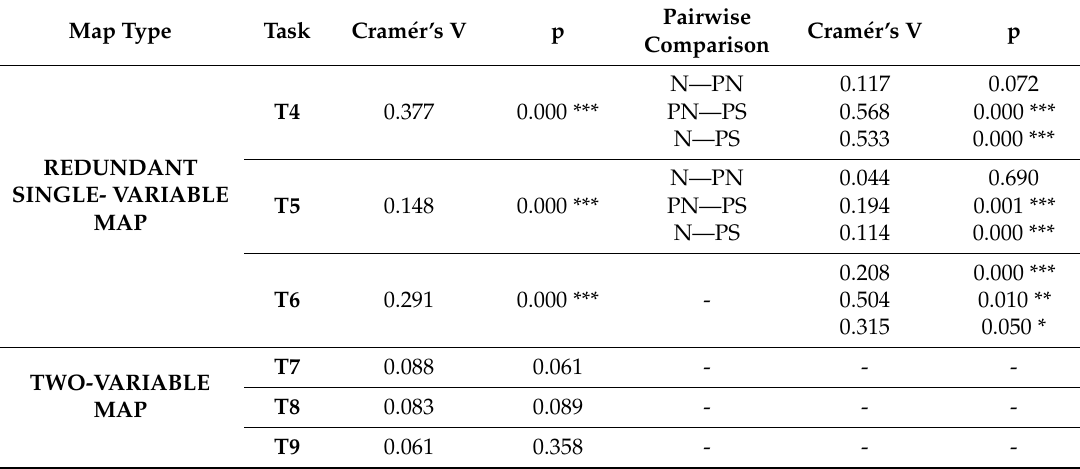
Table 5. Preferences towards methods of